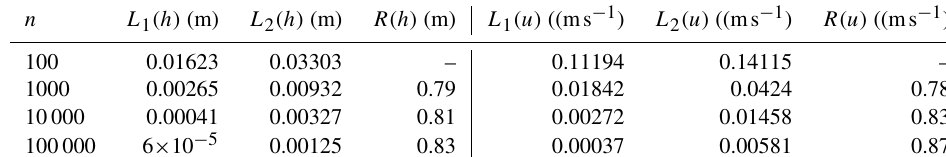
Table A2. Analytical dam break: L norms and empirical convergence rates ( R ) for water depth ( h ) and velocity ( u ).